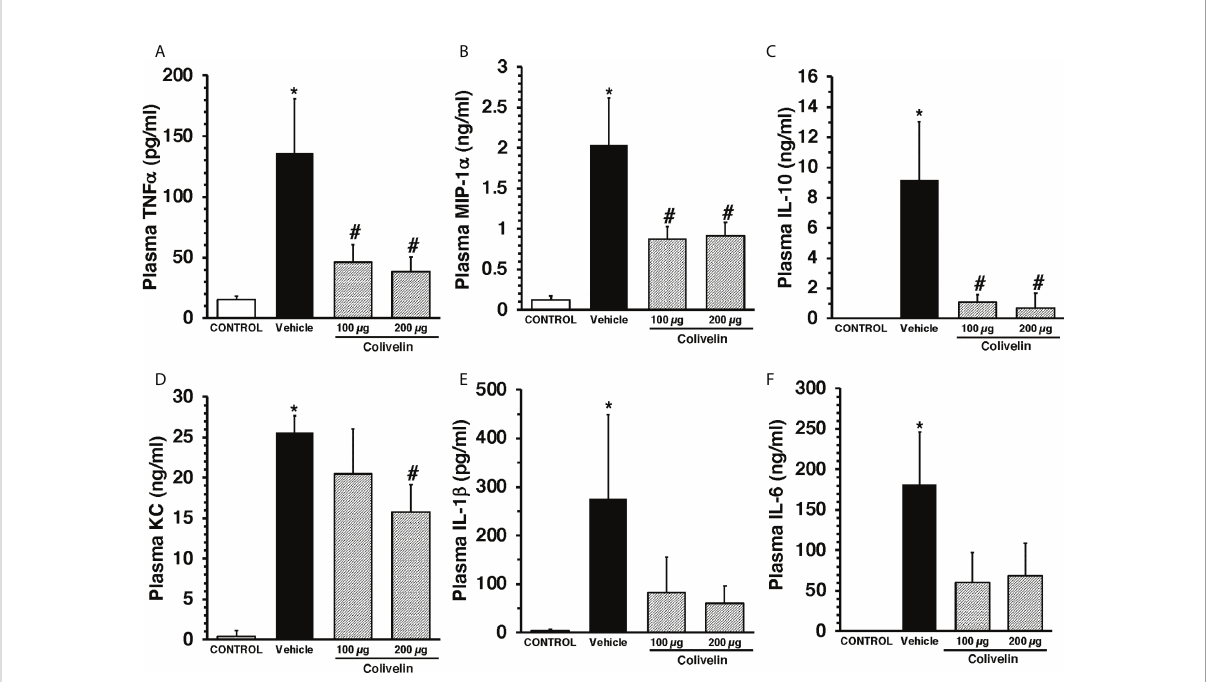
FIGURE 4 Plasma levels of TNF a (A) , MIP-1 a (B) , IL-10 (C) , KC (D) , IL-1 b (E) , and IL-6 (F) at 6 h after cecal ligation and puncture (CLP). Vehicle (200 µl distilled water) or colivelin (100 or 200 µg/kg) was administered intraperitoneally at 1 h after CLP. Data represents the mean ± SEM of 4-7 mice for group (n=4 control group, n=6 vehicle group, n=4 colivelin 100 µg group, n=7 colivelin 200 µg group). *Represents P < 0.05 versus control mice; #represents P < 0.05 versus vehicle-treated